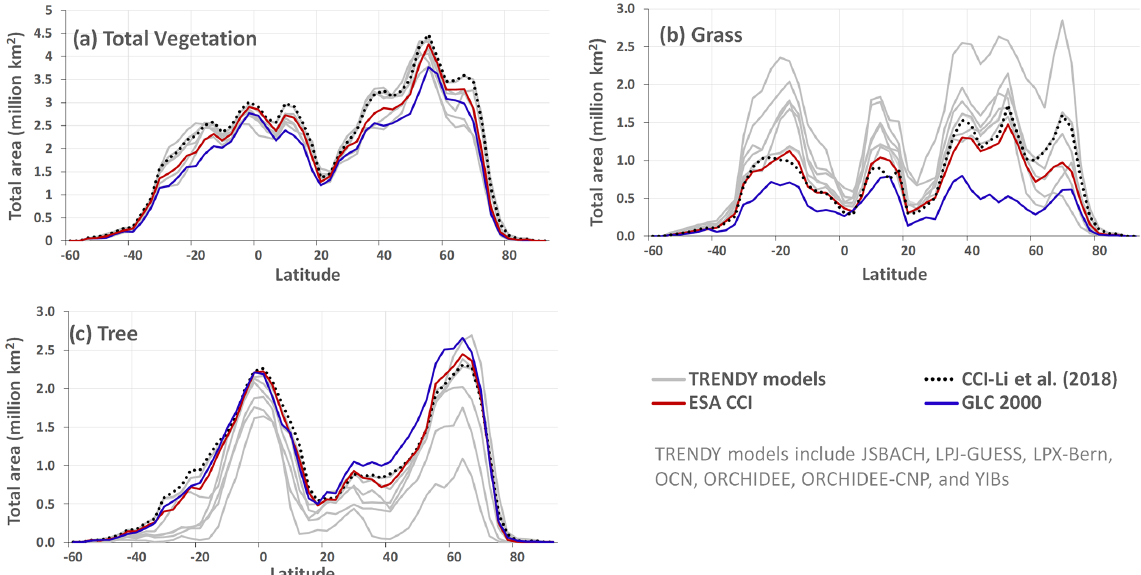
Figure 1. Comparison of zonally summed areas of total vegetation (a) , grass (b) , and tree (c) cover used in the CLASSIC model based on GLC 2000 (blue line) and ESA CCI (dark red line) land cover products to each other; to selected other models that participated in the 2020 TRENDY intercomparison (grey lines) for which land cover information was available; and to W. Li et al. (2018; dotted black line), who analyzed the ESA CCI data. All data correspond to the 1992–2018 period. CLASSIC does not yet explicitly represents shrub PFTs. Tall shrubs are merged into tree PFTs in CLASSIC. For the W. Li et al. (2018) data plotted here, the shrub PFTs are combined with the tree PFTs for a consistent comparison to